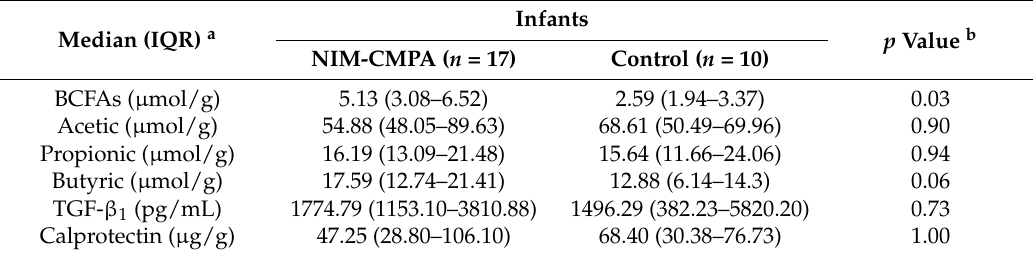
Table 2. Levels of main short-chain fatty acids (SCFAs), branched chain fatty acids (BCFAs), transforming growth factor- β 1 (TGF- β 1 ), and calprotectin excreted in feces of infants with non-IgE mediated cow’s milk protein allergy (NIM-CMPA) and infants in the control group. Median (IQR) a